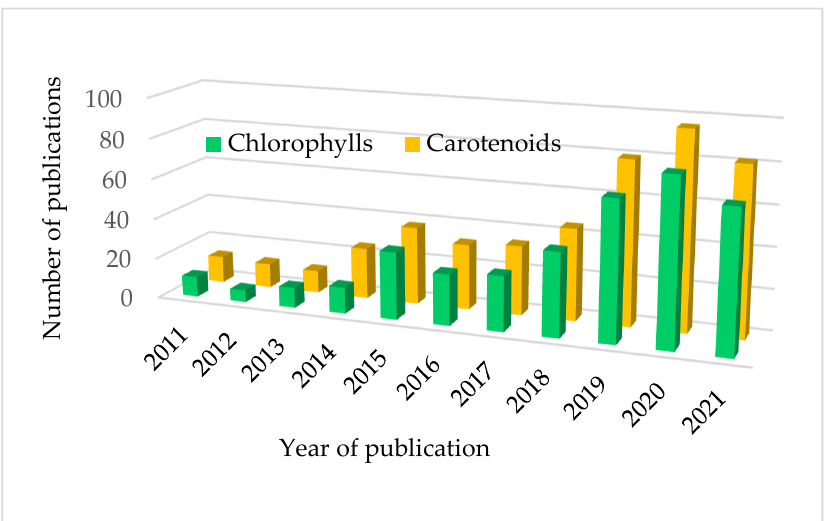
Figure 1. Number of publications since 2011 in the Web of Science (ISI Web of Knowledge) databases, introducing “metabolomic*” and “chlorophyll*” (green series) and “metabolomic*” and “carotenoid*” (orange series) as topics. The year 2021 does not cover the whole year and takes into account publications from January to September only.